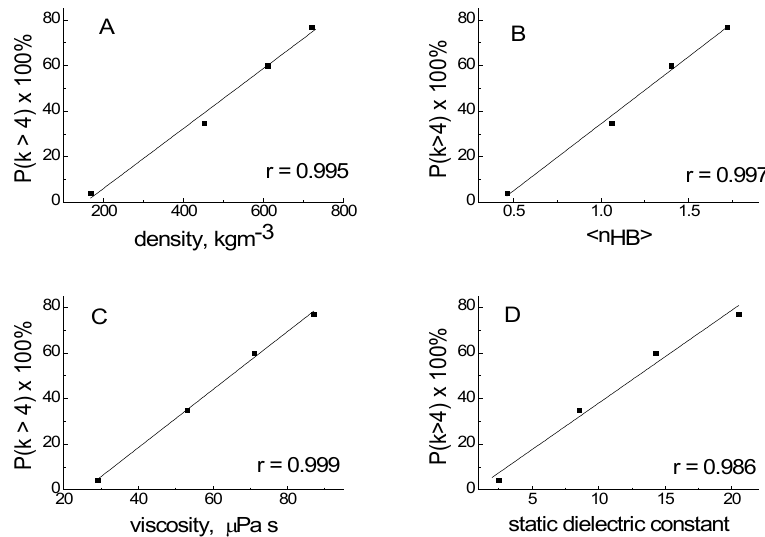
Figure 6. The probability P(k > 4) as defined in eq. (4) and calculated for TS2–TS5 versus: (A) density, (B) the calculated average number of H- > , (C) viscosity, (D) static dielectric constant. Lines represent linear least squares fits. Correlation coefficients bonds per molecule <n HB r are given in the